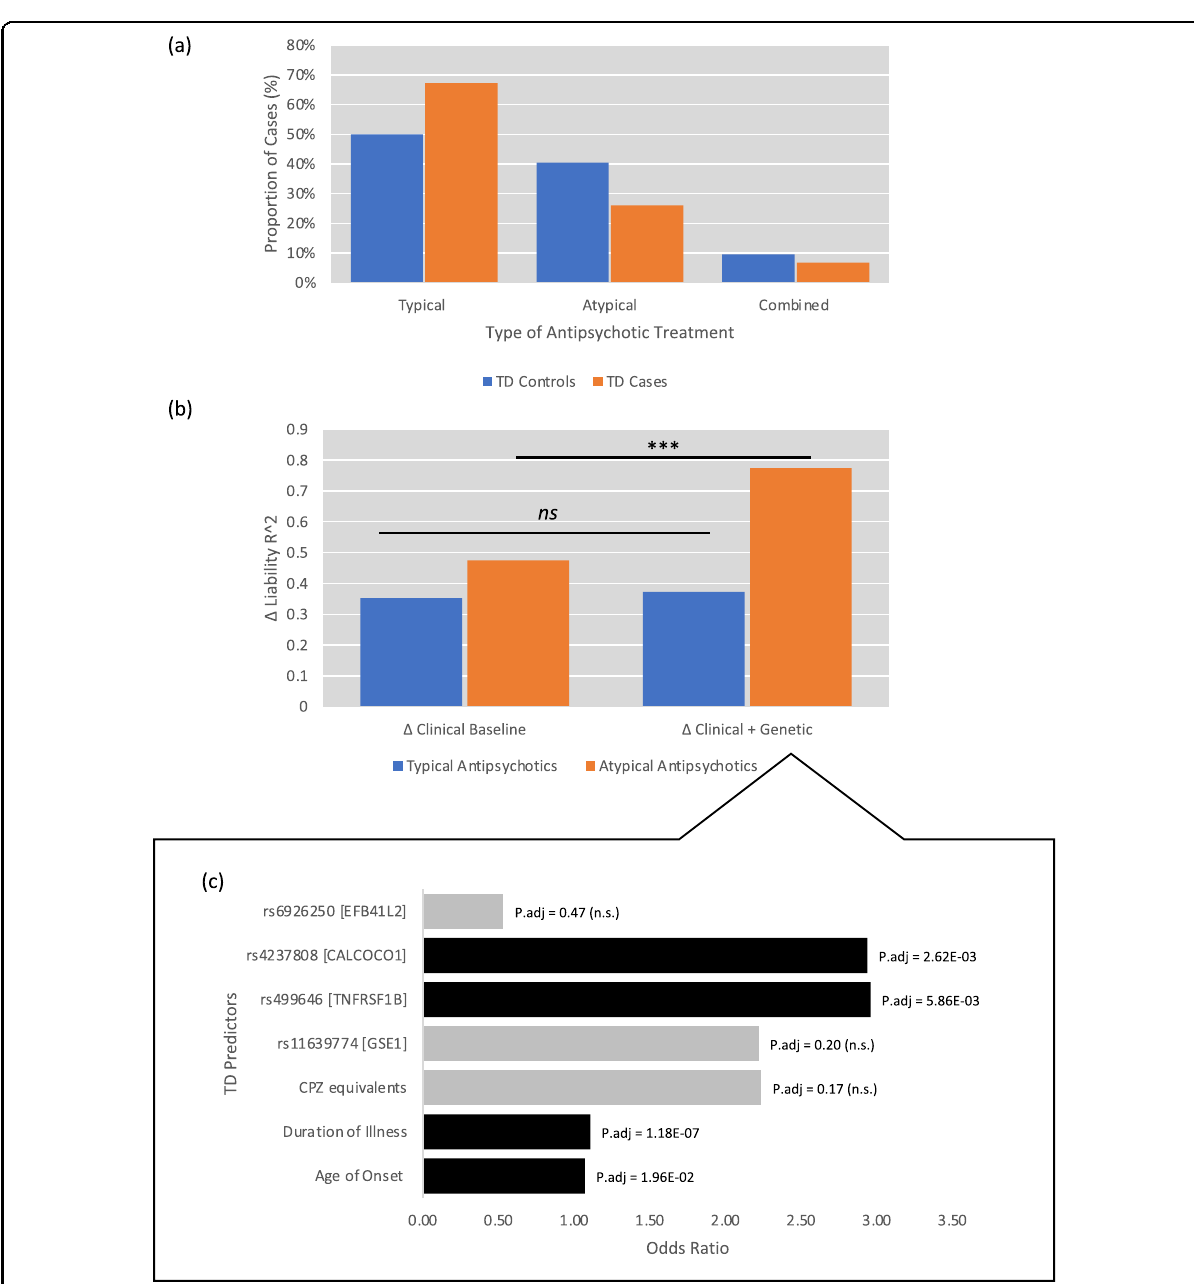
Fig. 4 Clinical and genetic risk factors for TD. a Strati fi ed analysis for antipsychotic type and TD b Logistic regression model for Clinical Baseline versus Clinical + Genetic Model. Y -axis: Liability scale R 2 for logistic regression model, case-control proportions adjusted for TD prevalence set at 15%. Clinical Baseline: Age of Onset, Duration of Illness, Daily CPZ equivalents. Clinical + Genetic: includes Clinical Baseline + rs6926250, rs4237808, rs499646, rs11639774. *** p = 7.09e-8. c Odds ratio for predictors in Clinical + Genetic model. Black colored bars are signi fi cant after Bonferroni correction for all variables entered in the logistic regression